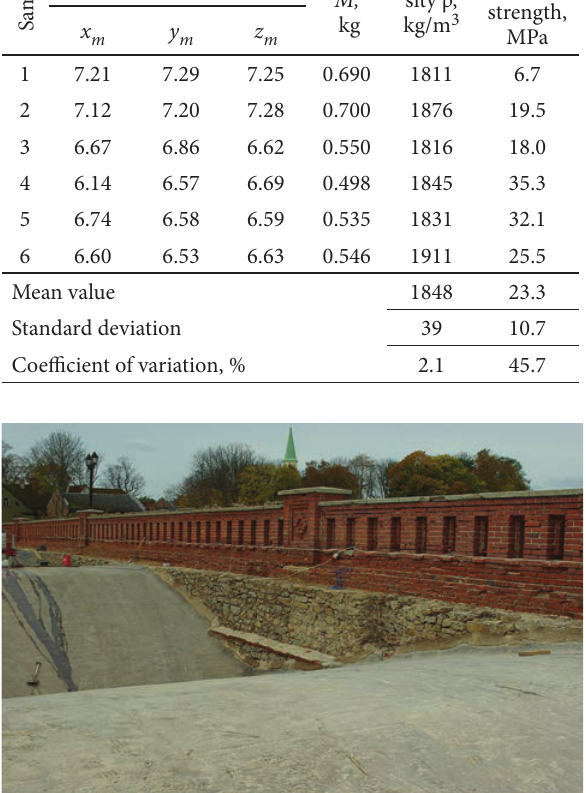
Fig. 10. Opened surfaces of brick arches showed remaining